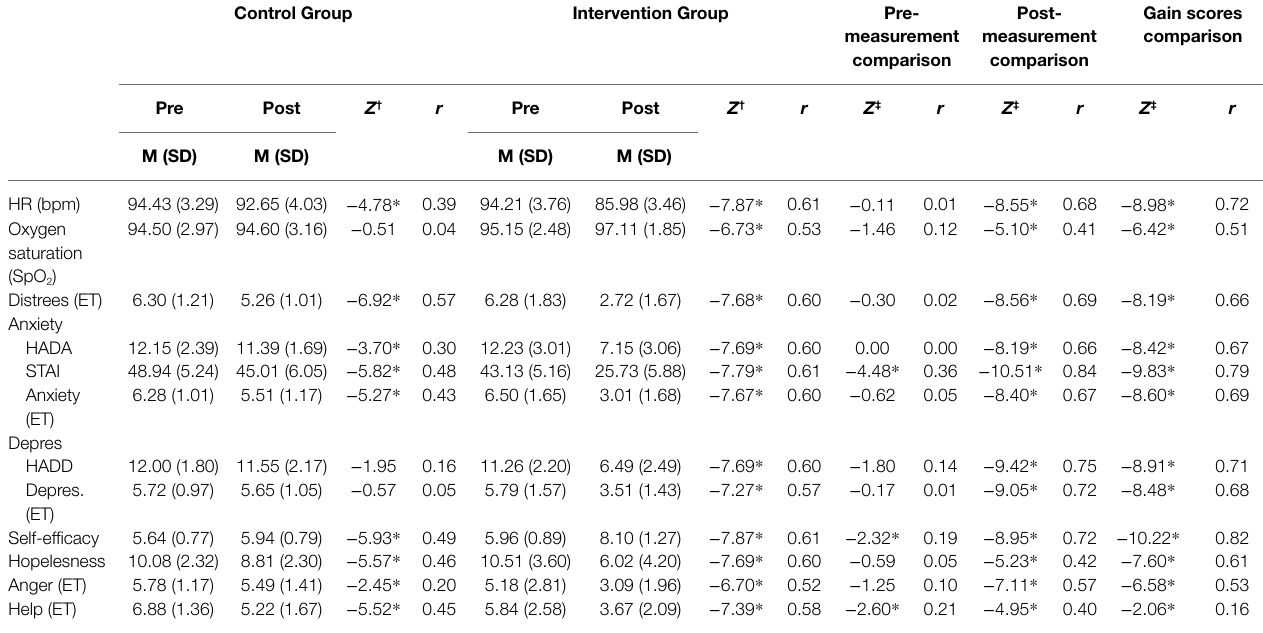
TABLE 3 | Means (SD) and summary statistics (Mann–Whitney U and Wilcoxon test) for pilot study variables comparing control and intervention group across pre- and post-measures. Control Group Intervention Group Pre-